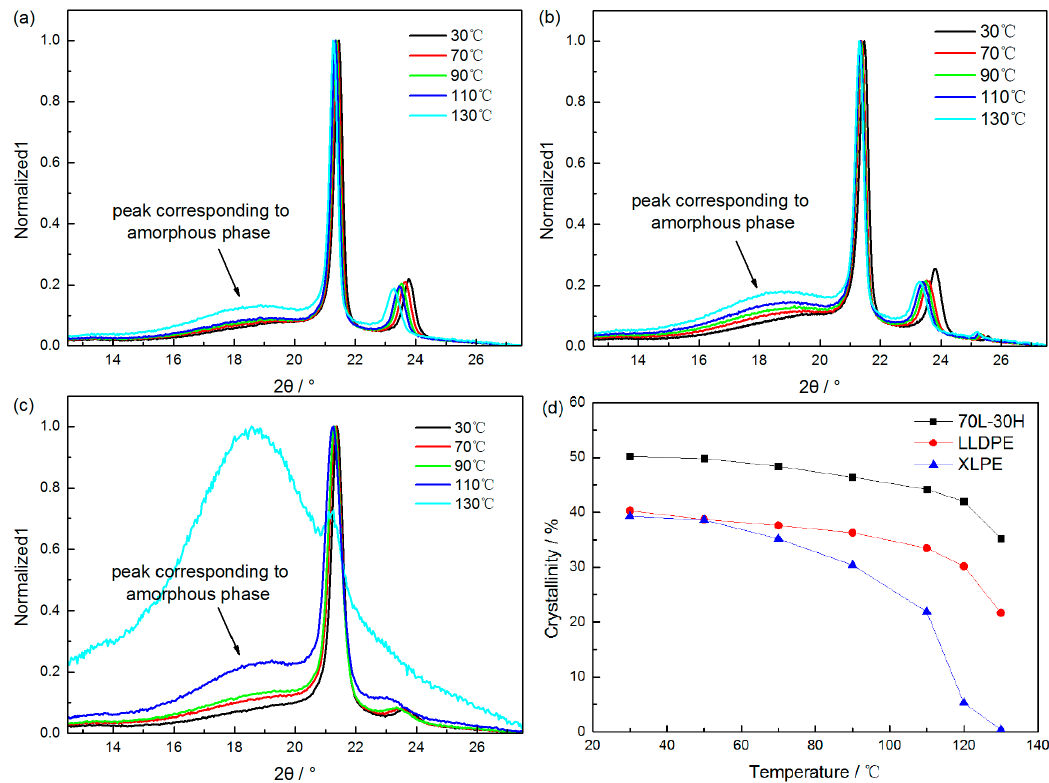
Figure 6. The XRD scanning spectrum for 70 L-30 H ( a ), LLDPE ( b ), XLPE ( c ) and the variation of crystallinity with temperature ( d ).